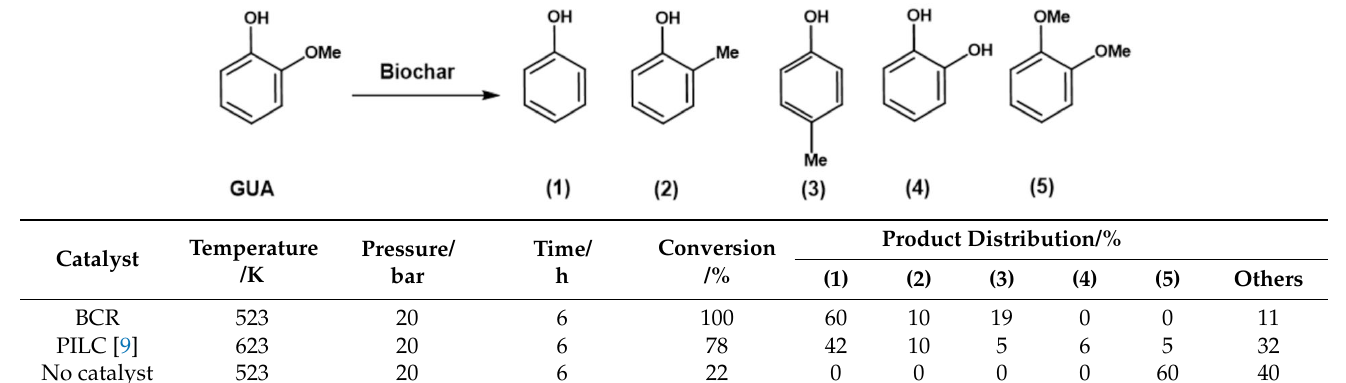
Figure 7. INS difference spectrum of ( a ) adsorbed water, ( b ) INS spectrum of ice I h , ( c ) infrared difference spectrum of adsorbed water, ( d ) infrared spectrum of ice I h and ( e ) infrared spectrum of liquid water. Table 4. HDO of GUA using BCR as the